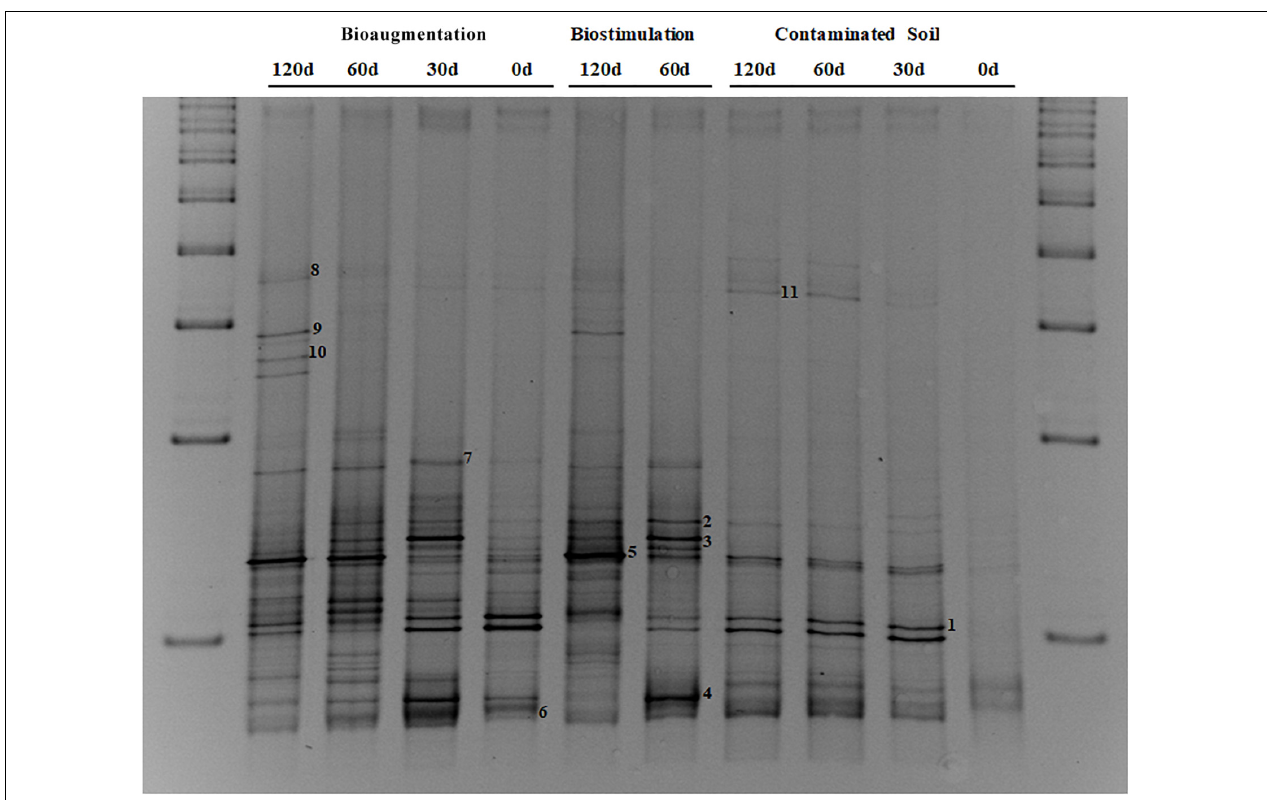
FIGURE 5 | DGGE profiles of bacterial 16S rDNA from microcosmos assays at 0, 30, 60, and 120 days of incubation. A standard ladder (L) has been added at both gel ends in order to check the DNA migration homogeneity. Bacterial bands have been named from B1 to B11.